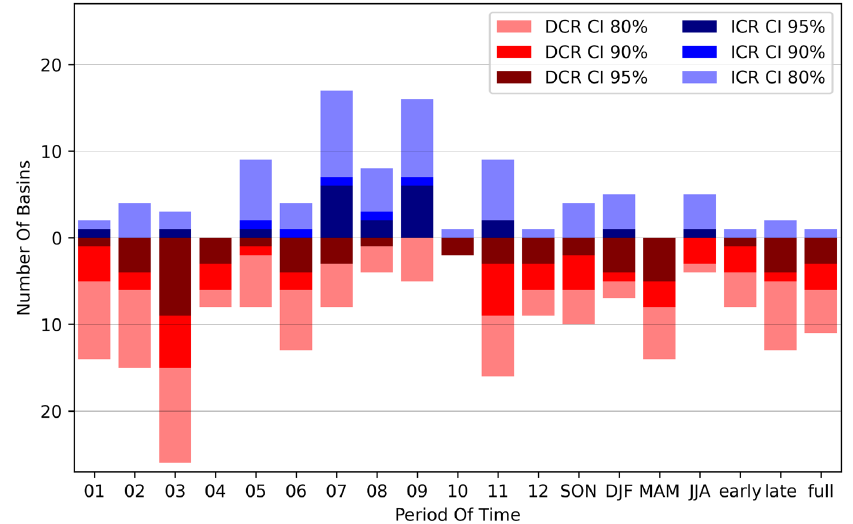
Figure 11. Overview of the results of the basin-based trend analyzes. It is shown how many major basins have a significant trend in the confidence intervals (CI) 80%, 90% and 95%. The decreasing (DCR) developments of the SCD are shown in red, the increasing (ICR) developments are shown in blue.